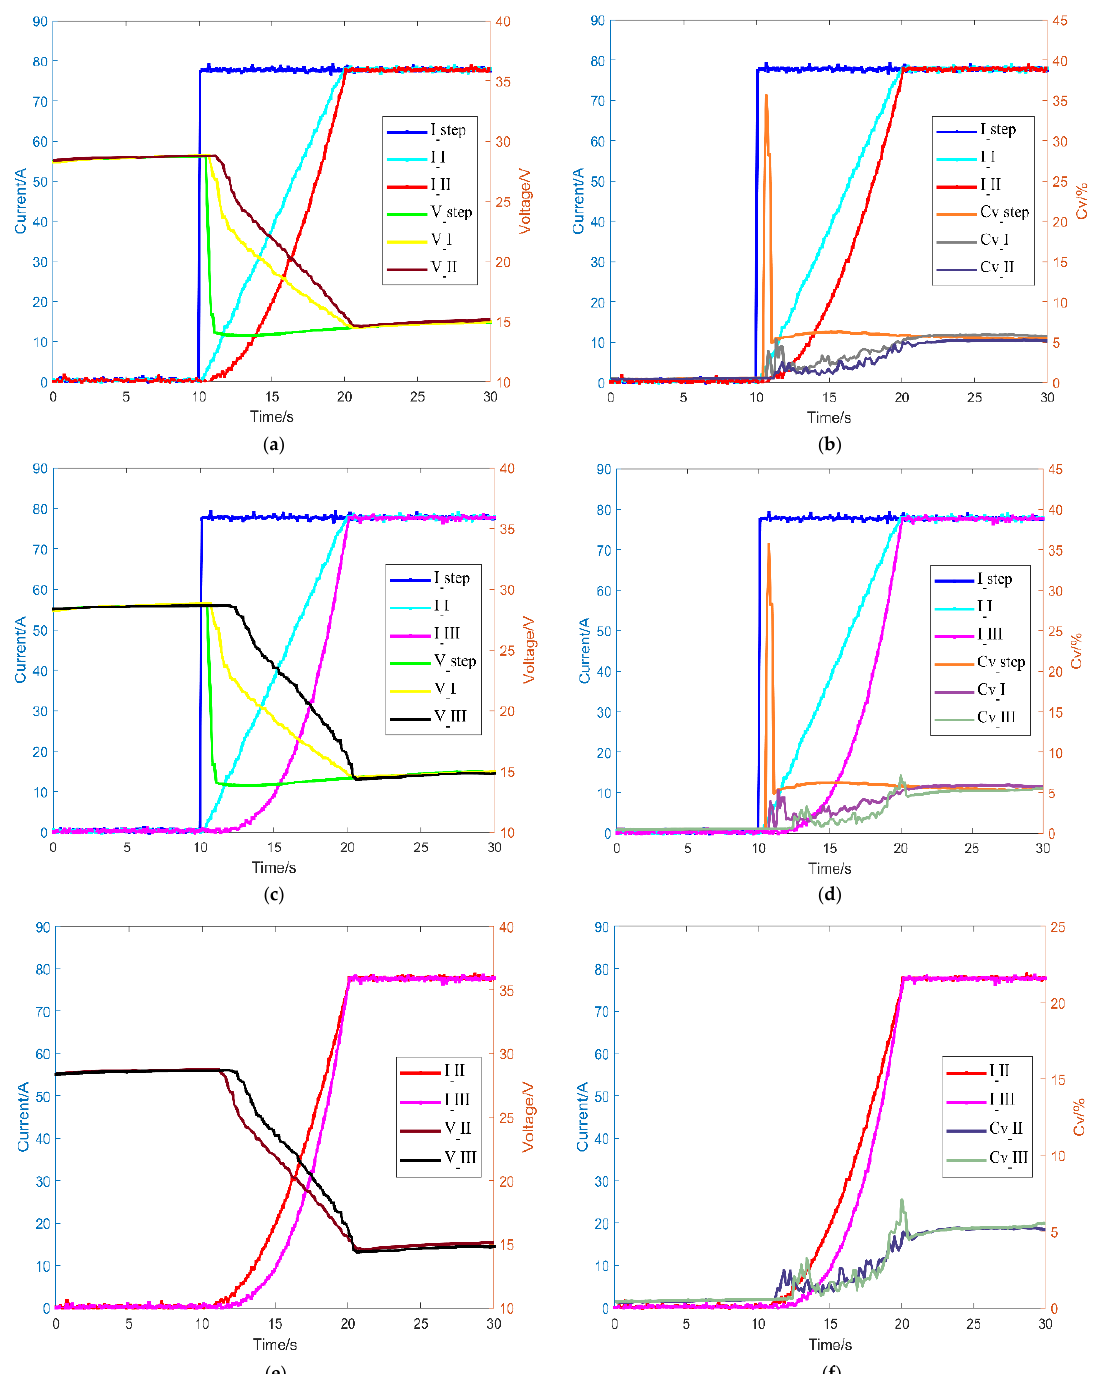
Figure 8. Comparison of output characteristics among step loading, constant loading rate, square increasing loading rate, and cure increasing loading rate strategy. ( a , c , e ) present exerting current and stack voltage; ( b , d , f ) present exerting current and Cv values.